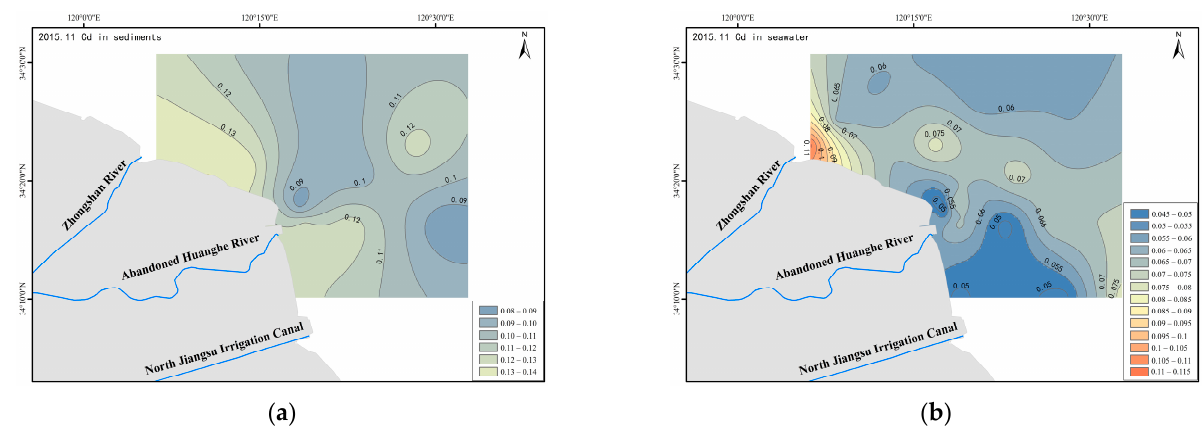
Figure 13. Spatial distribution of Cd in the sediment ( a ) and seawater ( b ) in 2015.